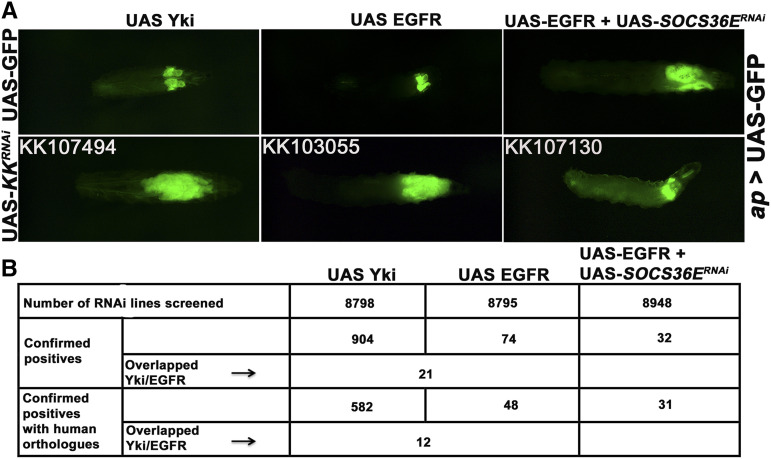
tumor formation/suppression visualized in intact larvae (A) Larvae co-expressed UAS-GFP with the indicated transgenes to permit visualization of the imaginal discs in the intact animal. All samples carried the ap-Gal4 driver and UAS-GFP. In addition, they carried either a second copy of UAS-GFP or one of the following: UAS-Yki, UAS-EGFR or UAS-EGFR+UAS-SOCS36ERNAi. (B) Table summarizing the number of RNAi lines screened and identified in the three large-scale screens (represents those many number of interacting genes).